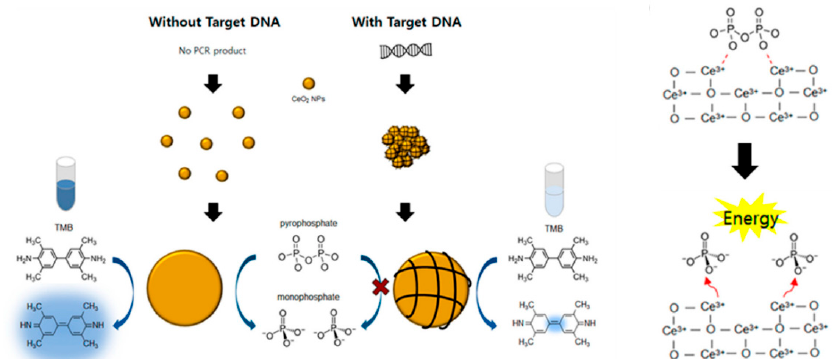
Figure 3. Schematic illustration of CeO 2 NPs-based colorimetric detection of target DNA using PPi as an enhancer. Reprinted with permission from Ref. [53]. Copyright 2021 MDPI.